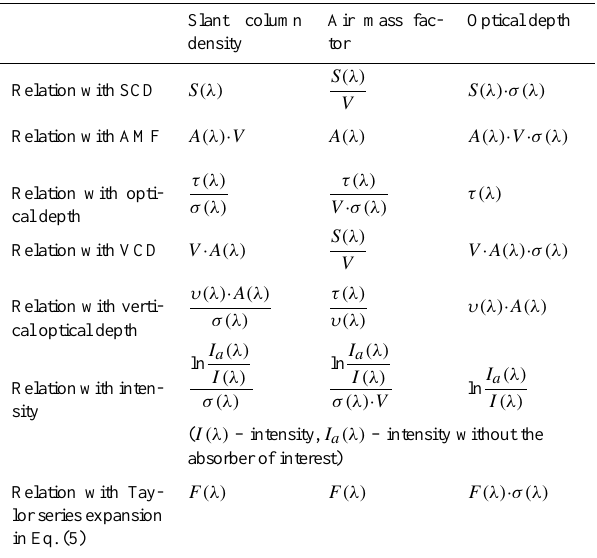
Slant column Air mass fac- Optical density tor